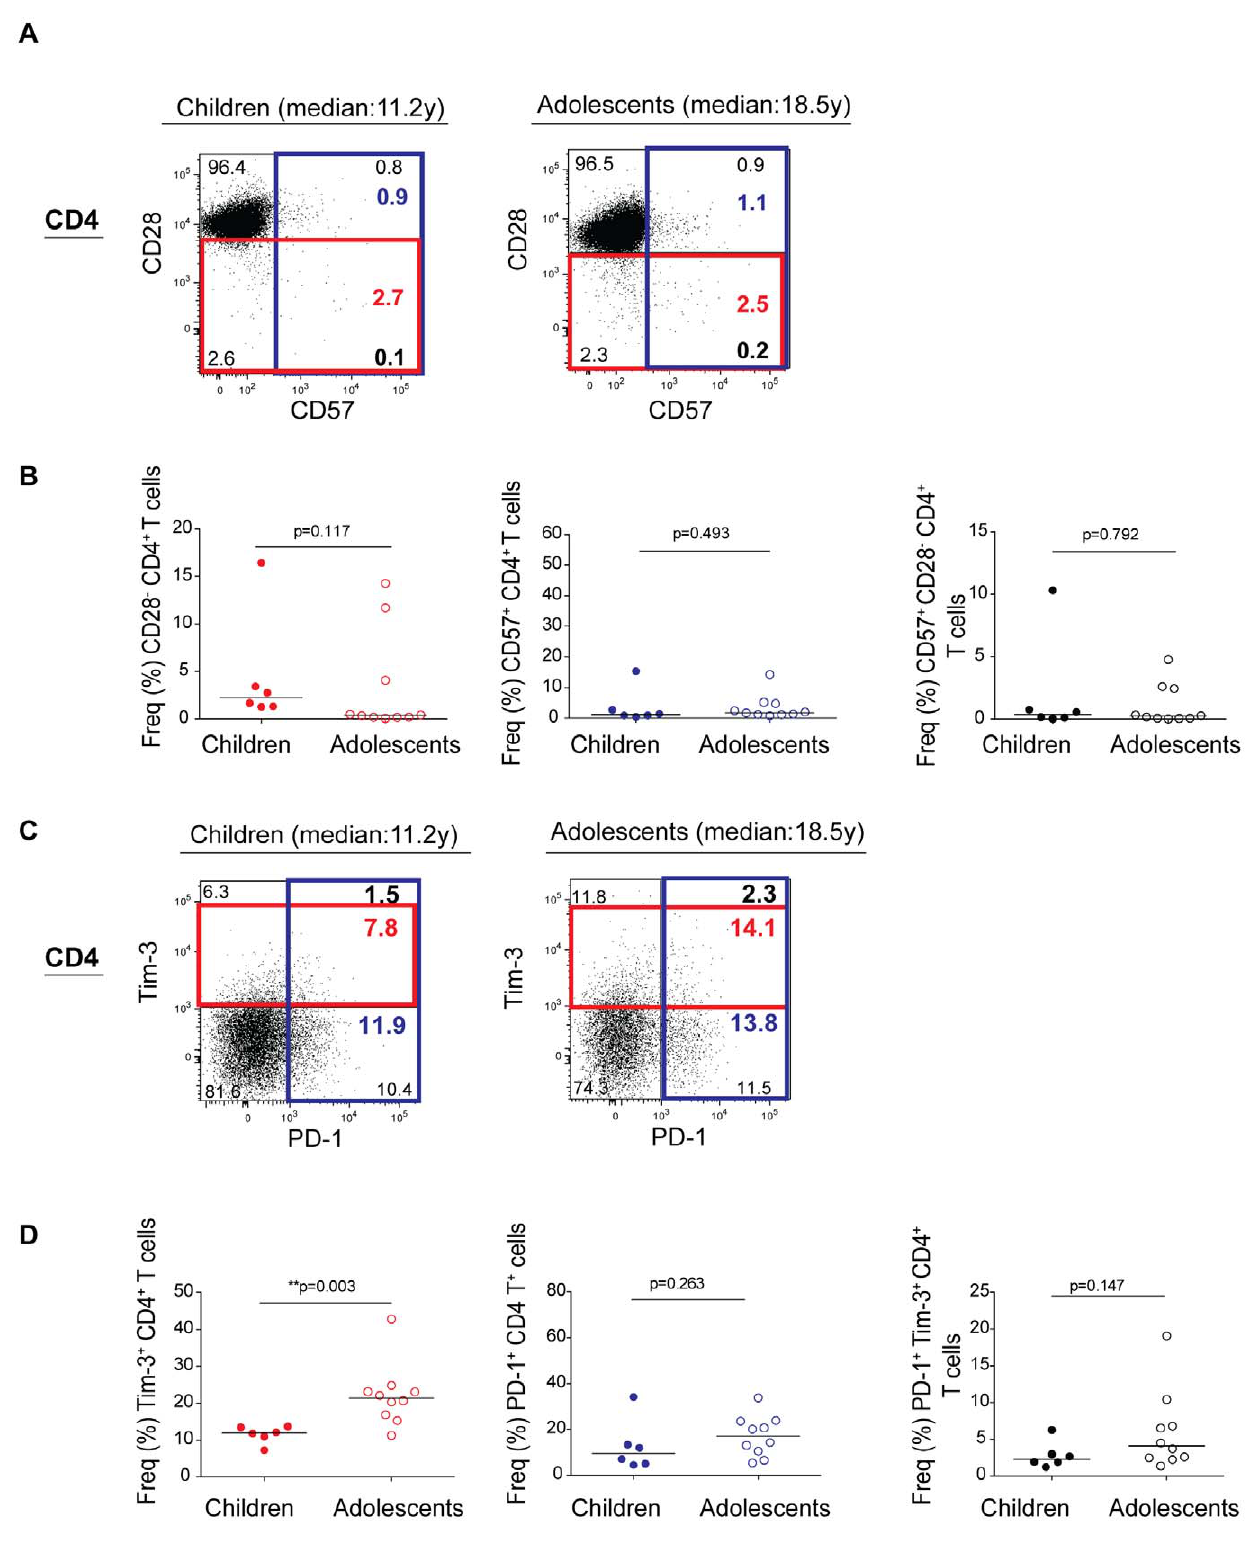
Figure 2. Expansion of Tim-3 + CD4 + T cells in perinatally HIV-1-infected adolescents. (A) Flow dot plots show CD4 + T cell surface expression of CD28 and CD57 in perinatally HIV-1-infected children with shorter duration of HIV-1 infection (median: 11.2 y) and adolescents with longer duration of HIV infection (median:18.5 y). (B) Frequencies of CD28 2 , CD57 + , and CD57 + CD28 2 CD4 + T cells in perinatally HIV-1-infected children and adolescents. (C) Flow dot plots show CD4 + T cell surface expression of PD-1 and Tim-3 in perinatally HIV-1-infected children with shorter duration of HIV infection (median: 11.2 y) and adolescents with longer duration of HIV-1 infection (median: 18.5 y). (D) Frequencies of Tim-3 + , PD-1 + , and PD-1 + Tim-3 + CD4 + T cells in perinatally HIV-1-infected children and adolescents. A significant increase in Tim-3 + CD4 + T cell (**p=0.003)